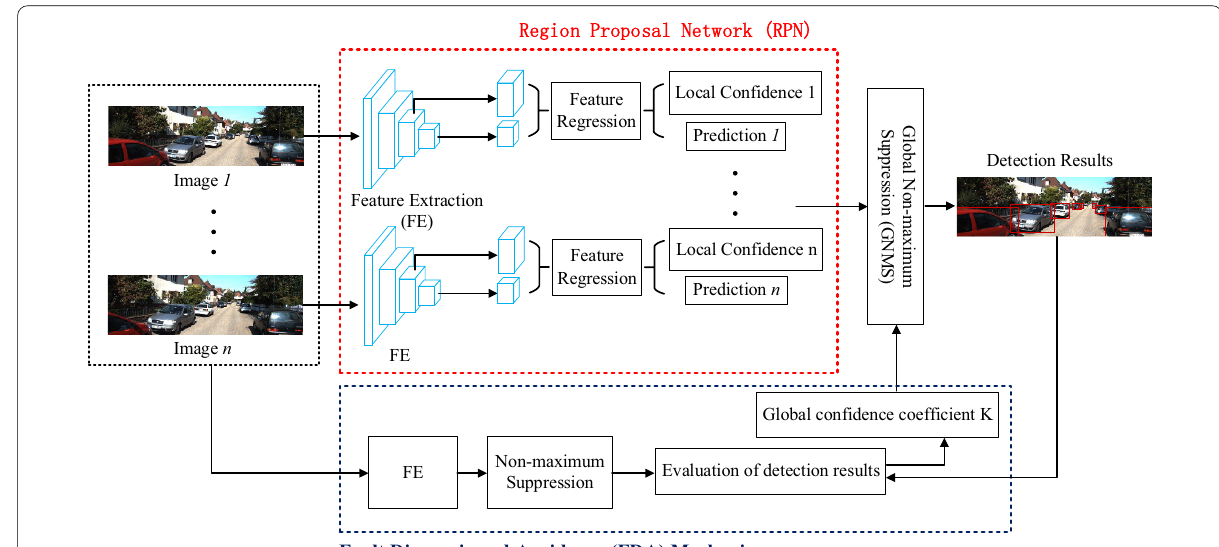
Figure 1 Data fusion